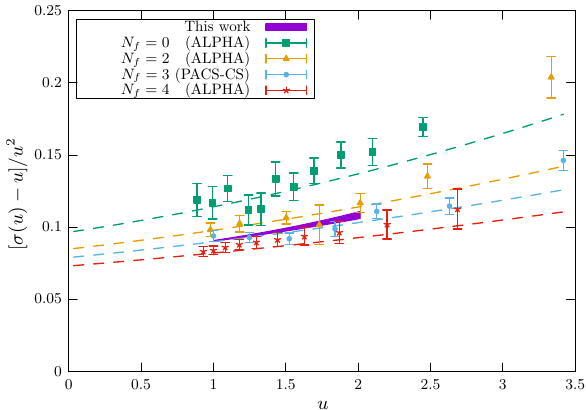
Fig. 1 The step scaling function σ( u ) , a discrete version of the β - function, defined in Eq. (2.29). The combination shown here yields directly the lowest order coefficient, b 0 of the β -function as (σ( u ) − u )/ u 2 = 2 b 0 ln 2 + O ( u ) .Thedashedlinesshowtheperturbative2-loop behavior. The purple 1-sigma band shows our result (fit C in Table 5). Data points for N f = 0 , 2 , 3 , 4 are taken from the literature